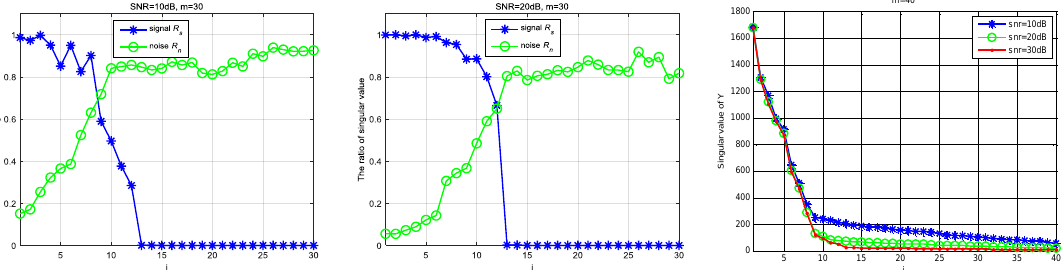
Figure 3. The contribution of the singular value of the signal and noise to total singular value.